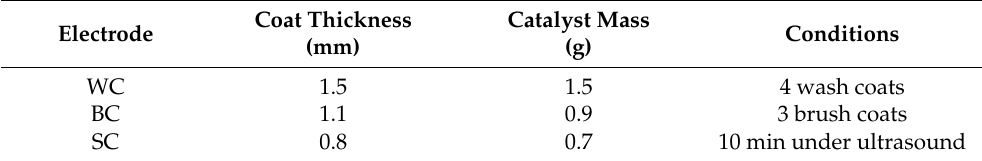
Figure 6. Polarization curves (V–I continuous lines) and power curves (P–I dashed lines) of the